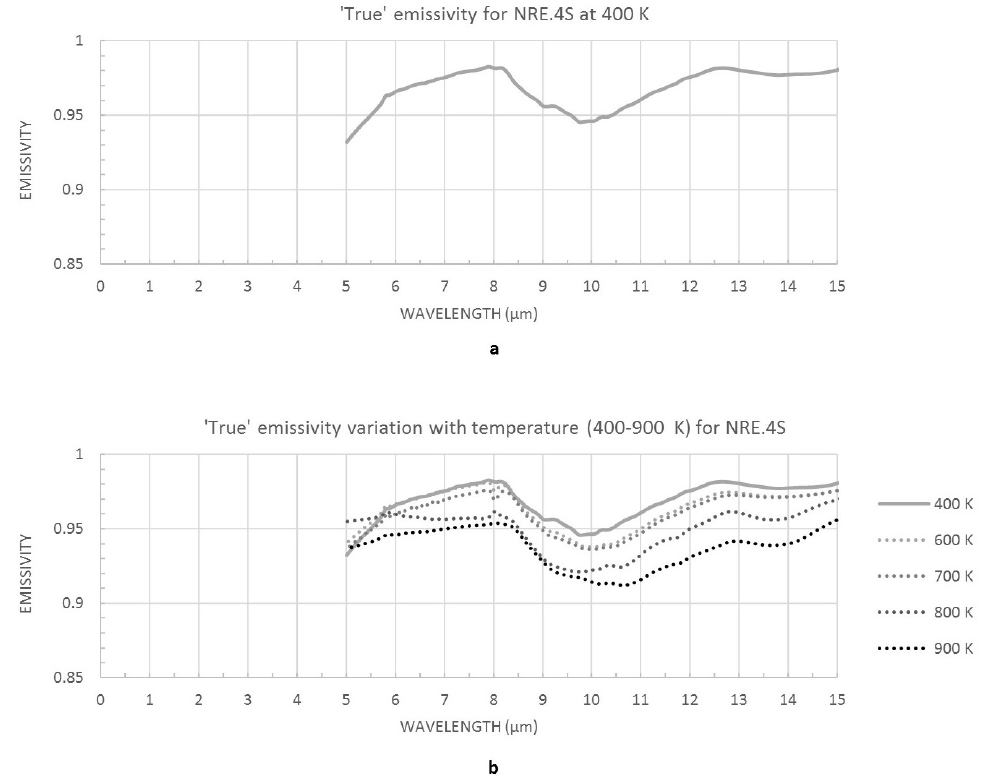
Figure 3. ( a ) ‘True’ emissivity ( ε ) spectral signatures at 400 K using thermal emission FTIR for NRE.4S; and ( b ) ‘true’ emissivity ( ε ) spectral signature variation with temperature change between 400–900